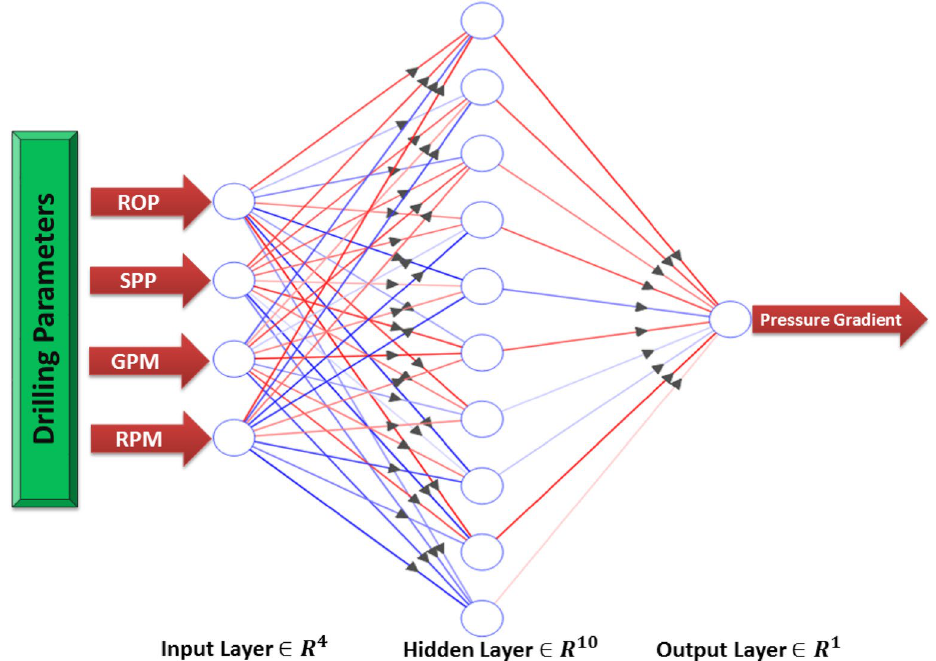
Figure 4. Schematic of the structure of the developed